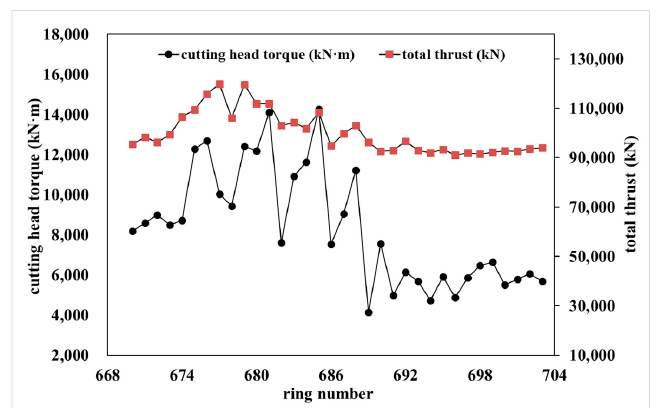
Figure 10. Changes of total thrust and cutting head torque of the machine at the Jinan Huanghe River Crossing tunnel